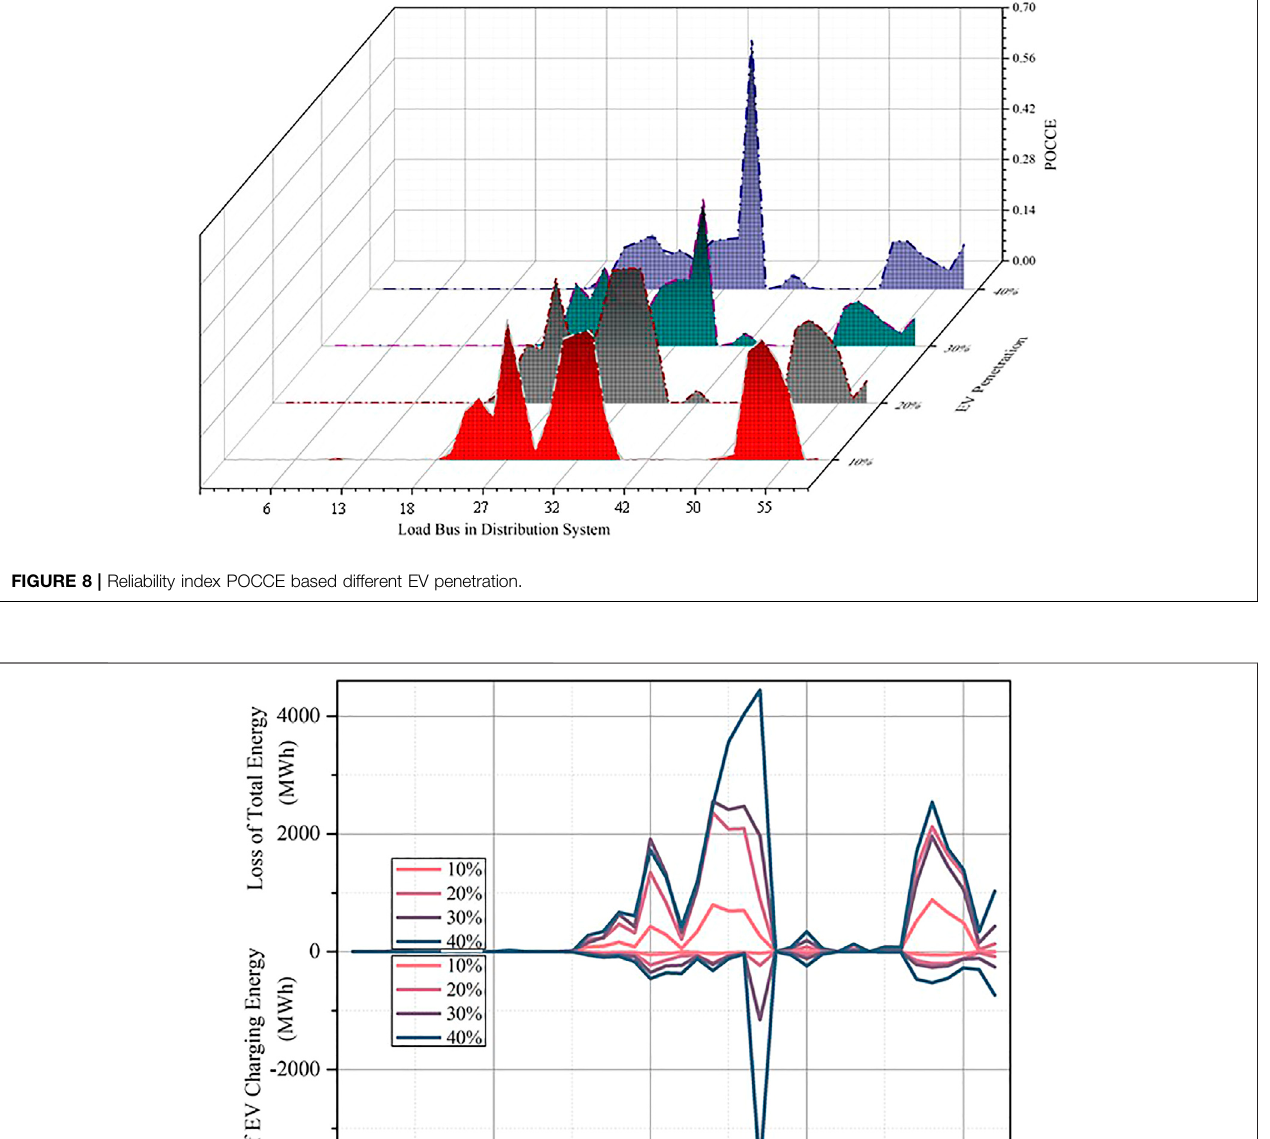
Frontiers in Energy Research |